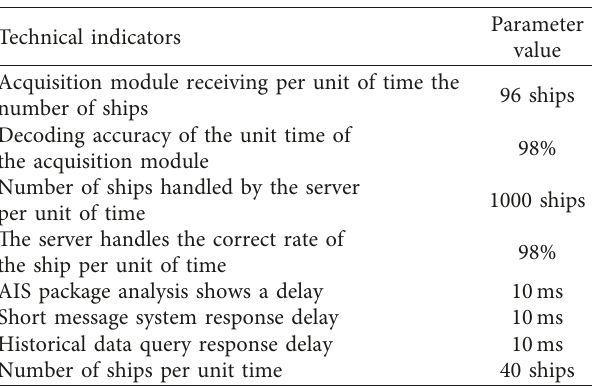
Table 1: Technical